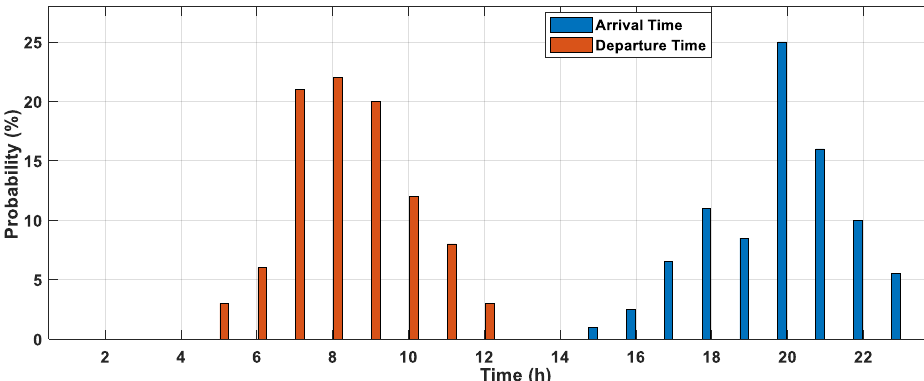
Figure 4. Arrival time and departure time [34].